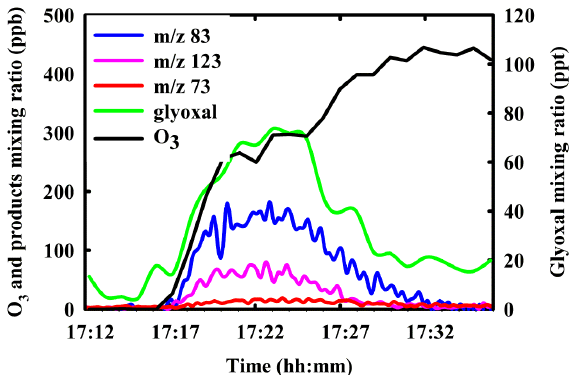
Fig. 5. Example of ozone and product profiles for a Type 2 LA experiment.